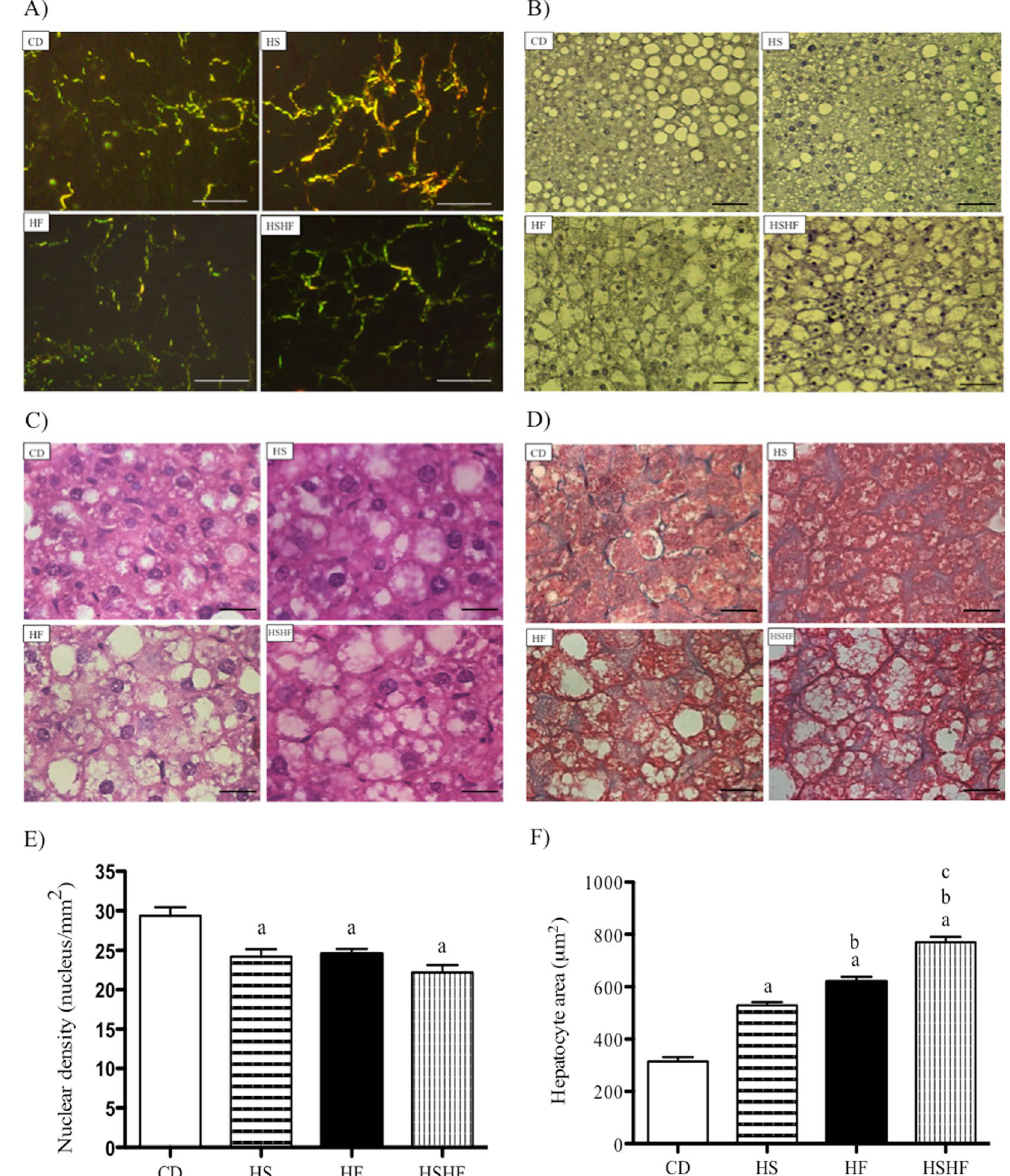
Figure 3. Photomicrographs illustrating the liver morphology of mice fed the control or obesogenic diets (high-sugar (HS), high-fat (HF) or high-sugar/high-fat diet (HSHF) for 8 weeks. ( A ) Picrosirius red staining; bar = 20 μ m; ( B ) Sudan black staining; bar = 10 μ m; ( C ) haematoxylin and eosin stain; bar = 20 μ m; ( D ) azo carmine; bar = 20 μ m; ( E ) nuclear density (nuclei/mm 2 ) using 5 random fields/3 sections/animal; and ( F ) area of hepatocytes ( μ m 2 ) measured in 45 cells per animal. The results are expressed as the mean ± S.E.M. (n = 4–7/ group). (a) P < 0.05 compared to CD, (b) P < 0.05 compared to HS, and (c) P < 0.05 compared to HF, using one- way ANOVA and Tukey’s